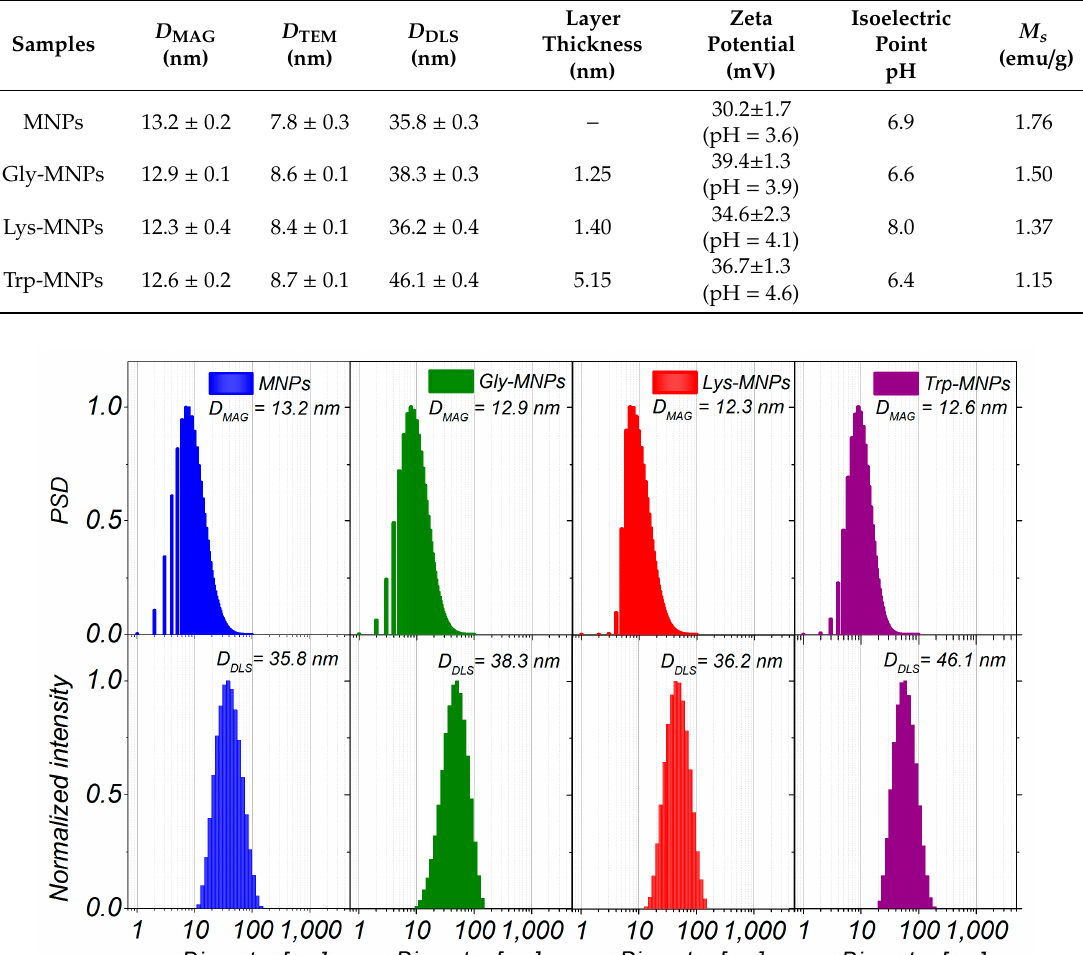
Table 2. Physico-chemical properties of MNPs and AA–MNPs obtained by di ff erent techniques. *The pH at which the zeta potential value has been determined.